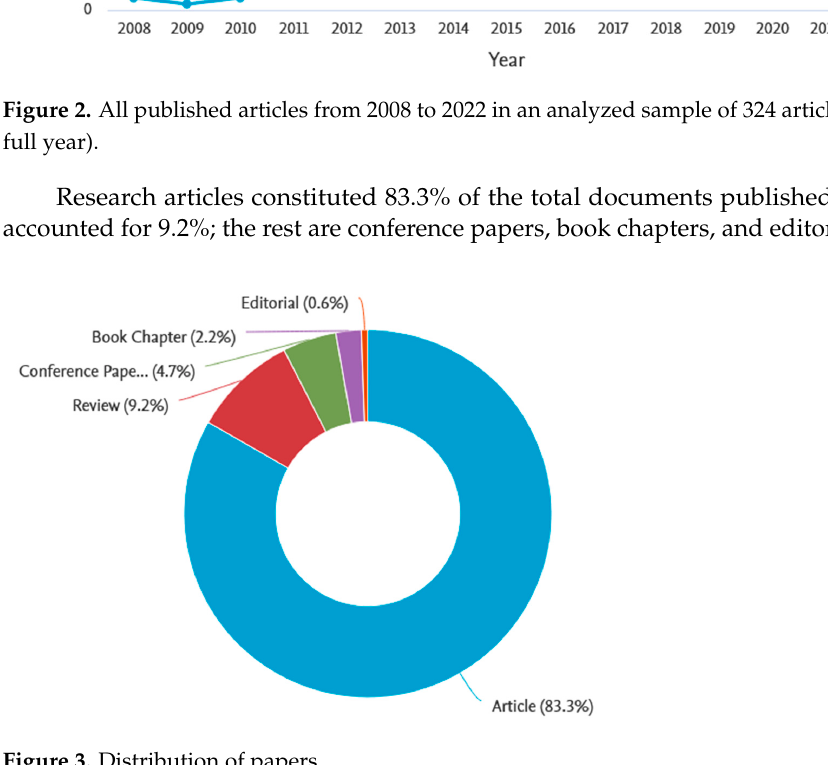
Figure 3. Distribution of papers.